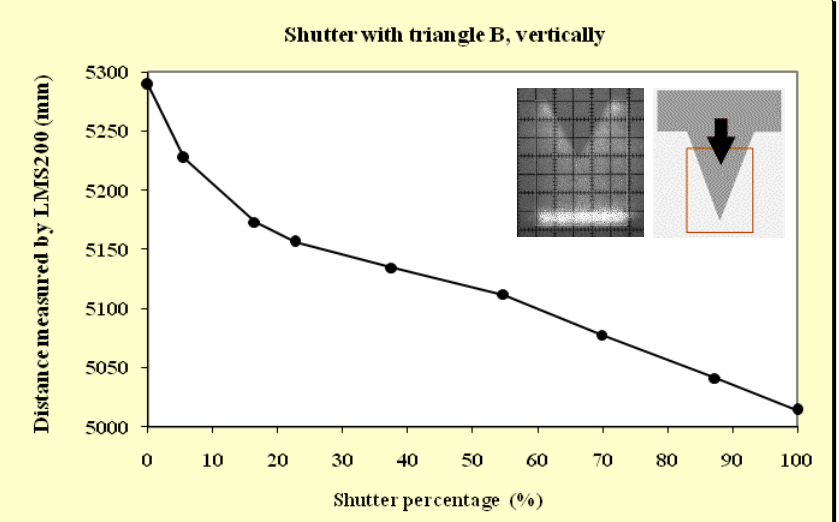
Figure 12. Graphic representation of the evolution of the distance measurement given by the sensor when the laser beam (90°) was incrementally blocked (from top to bottom) using the triangular shaped template B at a distance of 5 m from the sensor and the unblocked part of the beam was captured by the grid template at a distance of 5.3